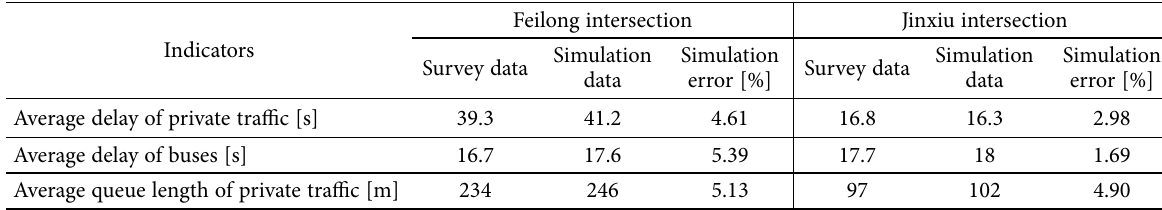
Table 1. Comparison of simulation and survey